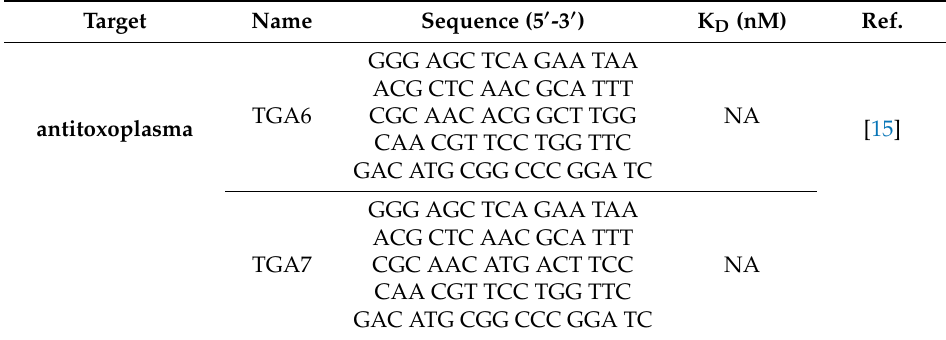
Table 7. Aptamers against antitoxoplasma, used in sandwich assay.